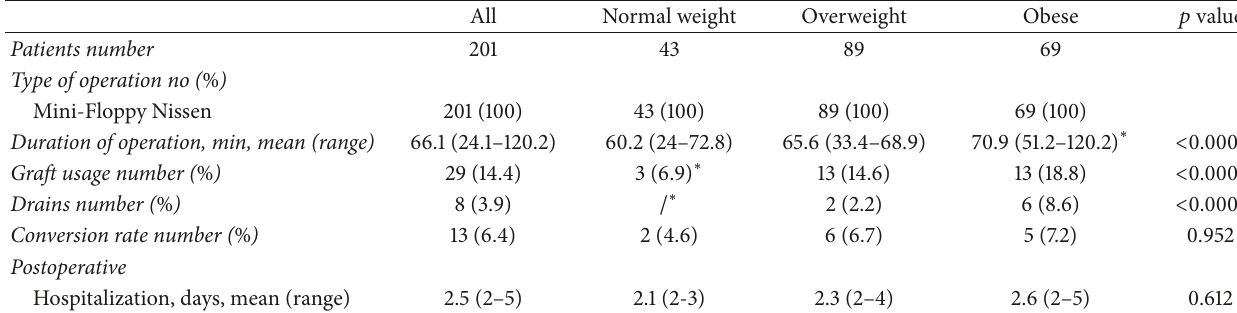
Table 3: Perioperative